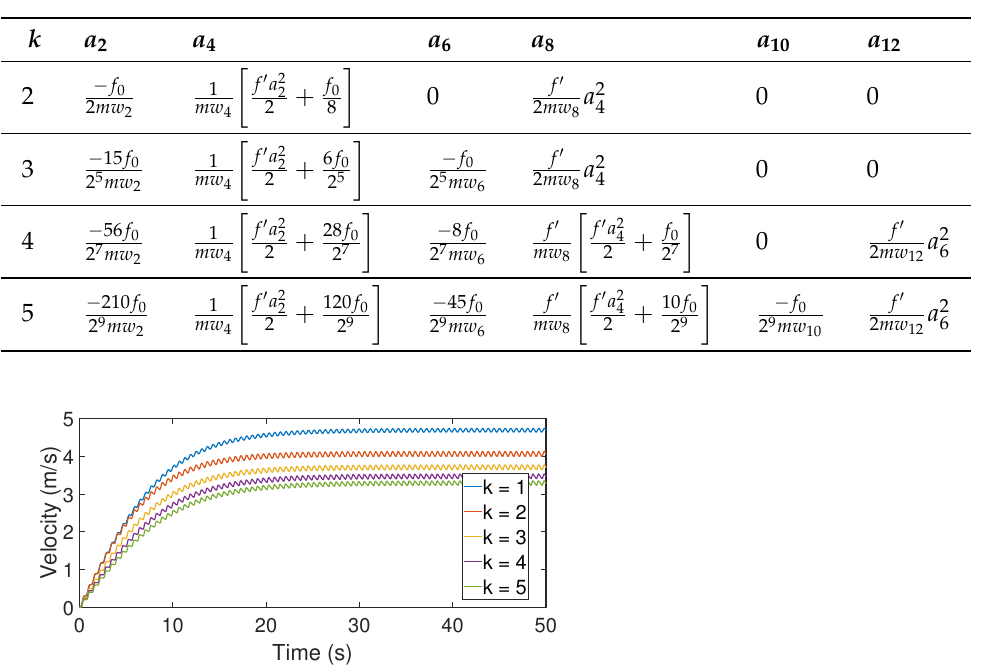
Figure 7. Velocity versus time with m = 90 kg, f 0 = 120 N, d = 2.72 kg/m y w = 1.66 · π rad/s (100 strokes/minute), for the stroke function f = f 0 sin 2 k ( wt ) and different values of the parameter k (see